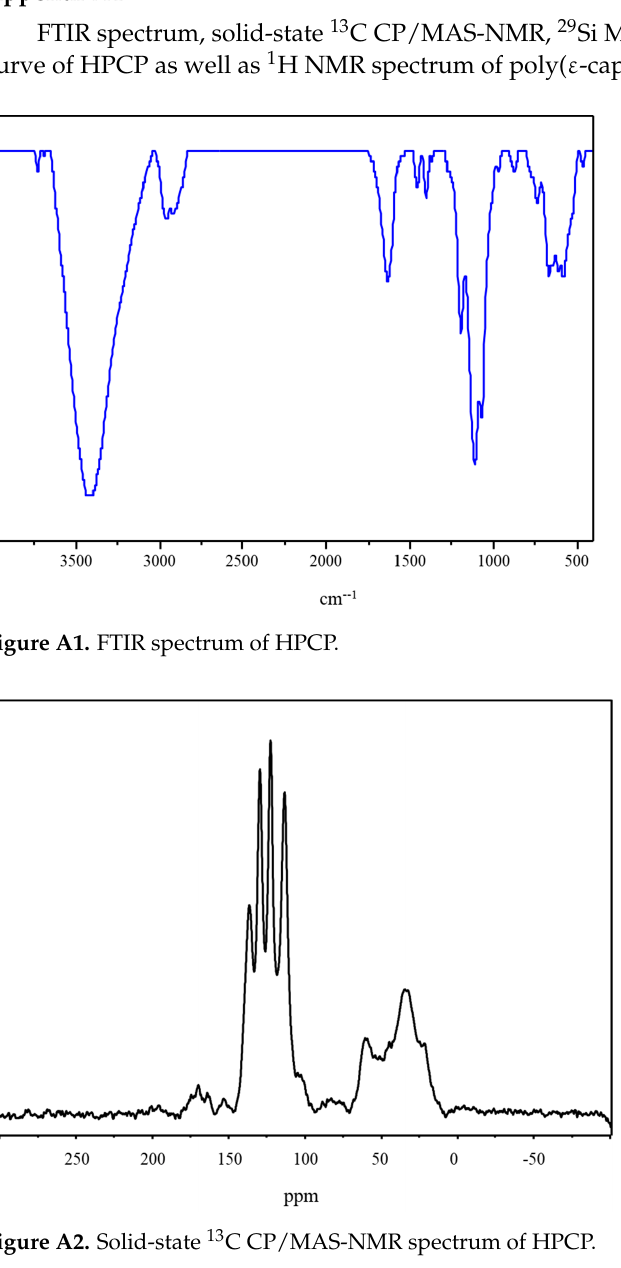
Figure A3. Solid-state 29 Si MAS NMR spectrum of HPCP.